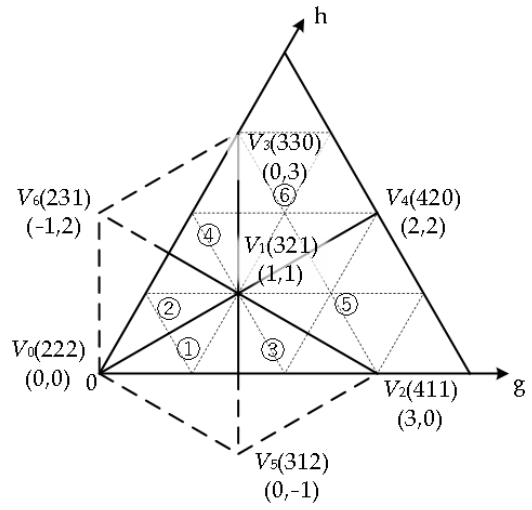
Figure 7. The sector division of 0CMV-SVPWM. Table 3. The action order of 0CMV-SVPWM synthesis vectors. Table 4. The action time of the 0CMV-SVPWM synthetic vector.